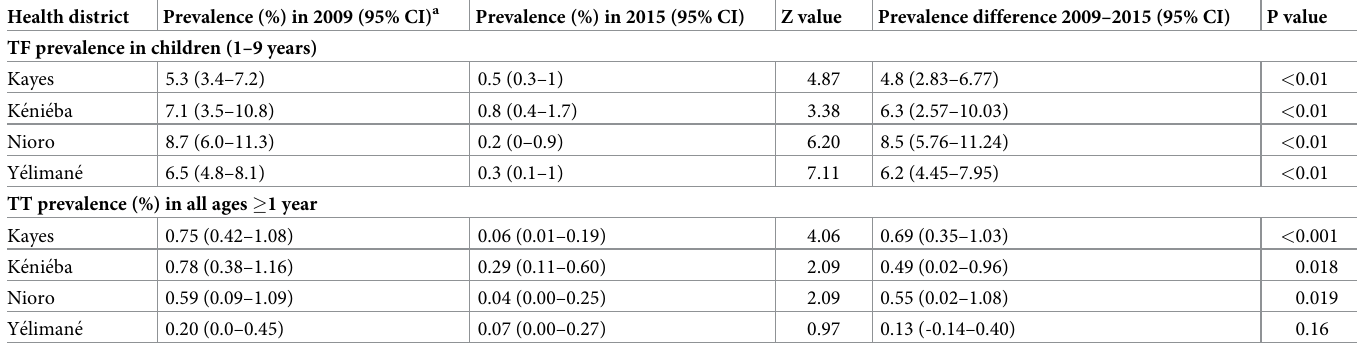
Table 3. Comparison of trachoma TF and TT prevalence between 2009 and 2015.